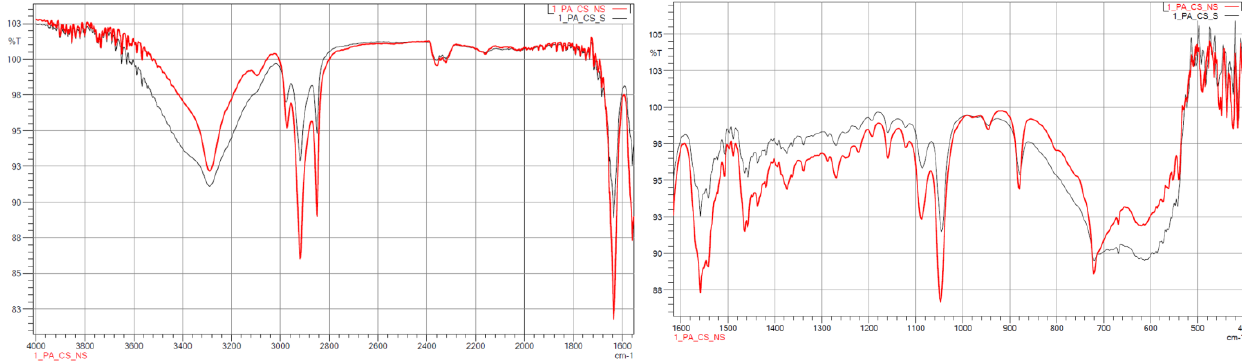
Figure 10. IR spectra for PA12_CS non ‐ sterilised (red curves) and sterilised (black curves) samples. Table 8. IR band description for PA12_ZrO 2 , PA12_Al 2 O 3 , and PA12_CS samples. Table 7. IR band description for PA-12 samples.